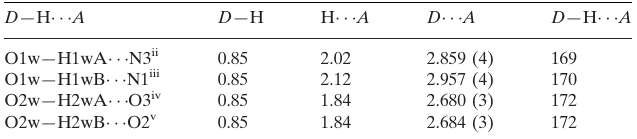
Hydrogen-bond geometry (A˚ , (cid:3)